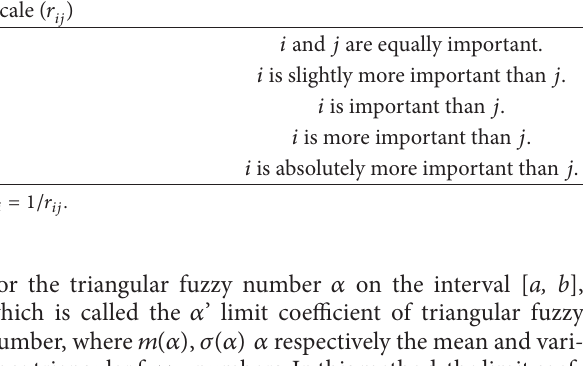
Figure 3: Triangular fuzzy numbers.